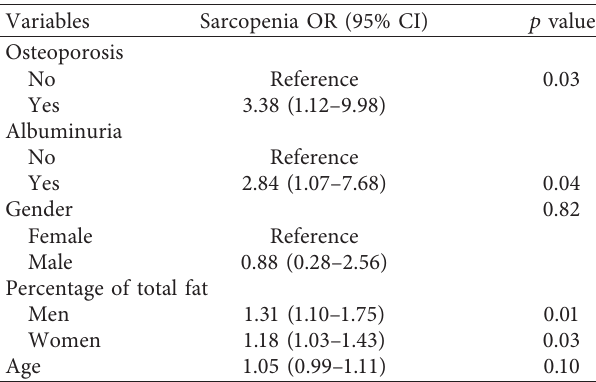
Table 4: Odds of sarcopenia and associated variables in partici- pants in the type 2 diabetes mellitus group (T2DMG).